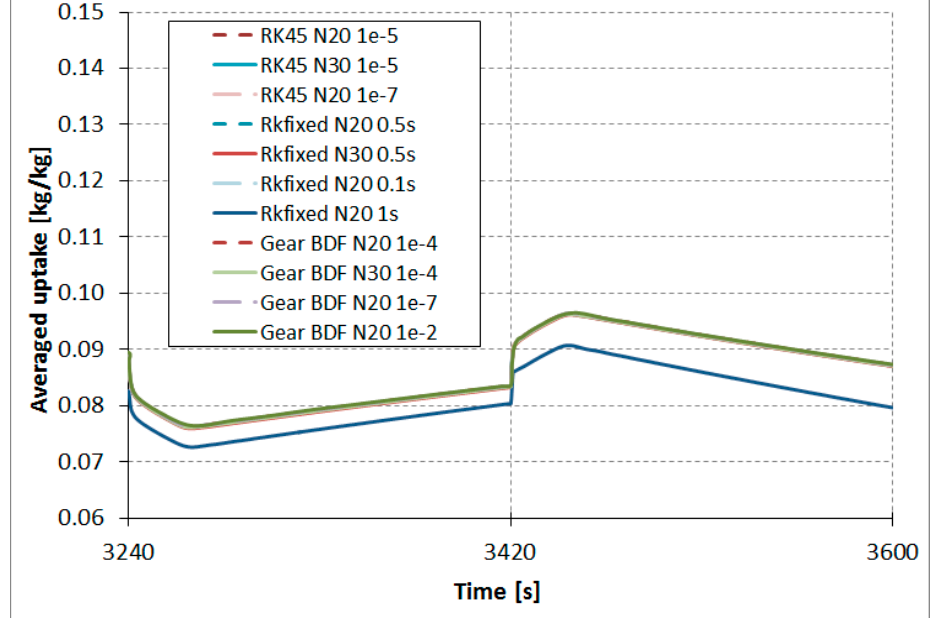
Figure 9. Results comparison of the RKfixed, RK45, and Gear BDF methods in different accuracies and discretizations, calculated averaged uptake (cid:1853) .